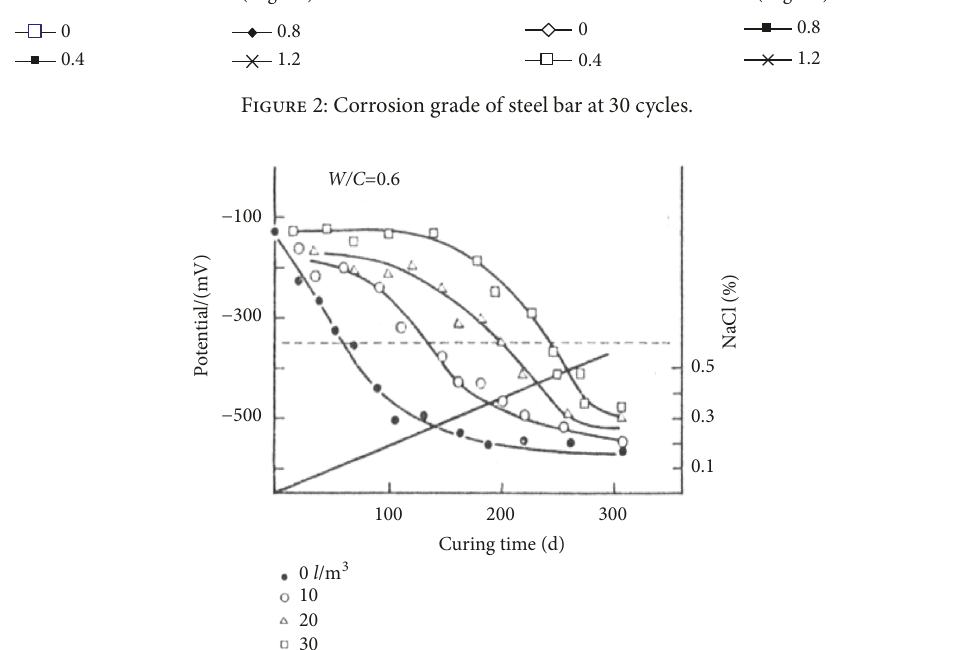
Figure 3: Variation of NaCl concentration and